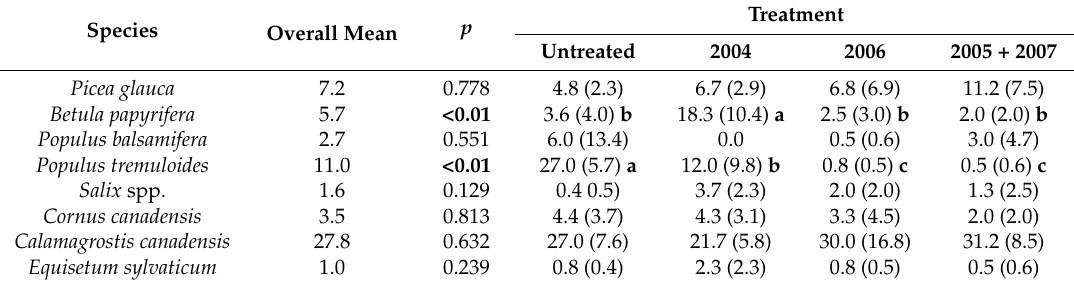
Table 5. Effects of treatments on cover of selected species. Standard deviation is shown in brackets () beside each mean. Where Analysis of Variance indicates significant treatment effects ( p < 0.10), p values are shown in bold and bold letters are used to indicate differences between treatments determined using Tukey’s HSD test ( p < 0.10).